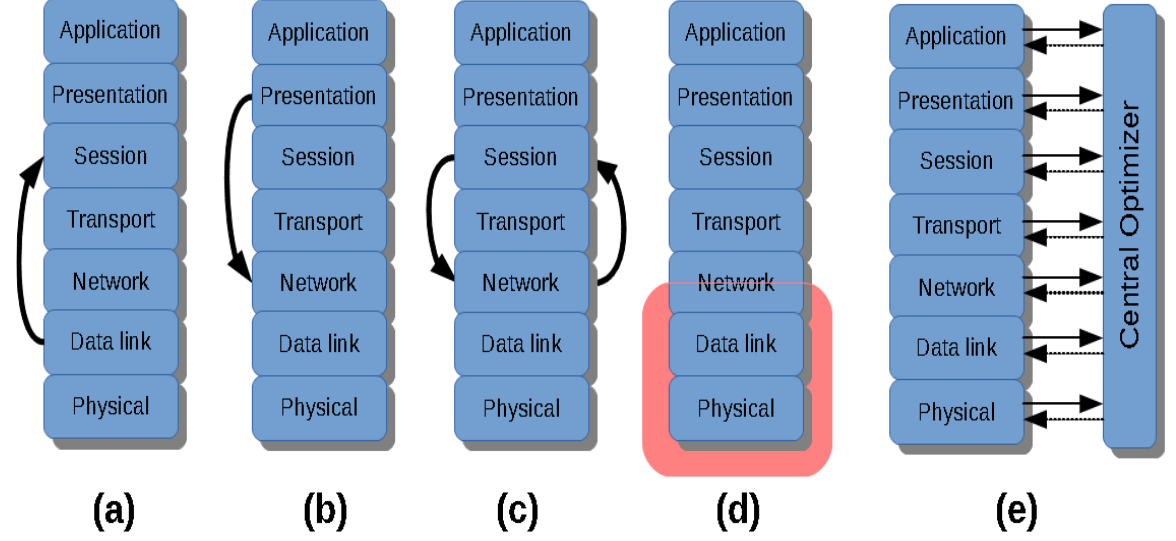
Figure 1. Examples of common cross-layer design protocols Fig. 1a-c create new interfaces between non-adjacent layers to allow information exchange. Certain layer can directly provide internal protocol parameters to other layers.